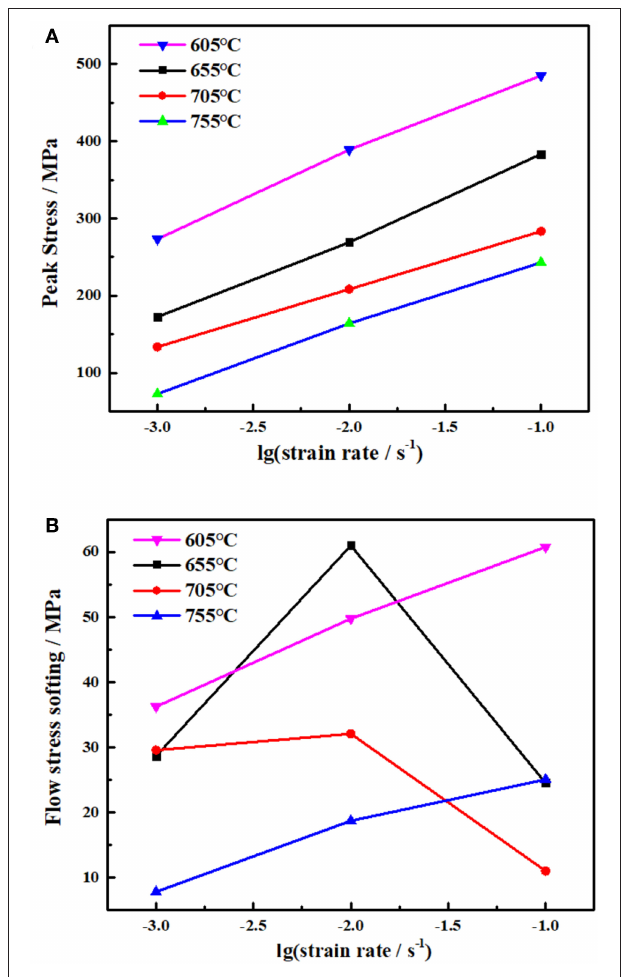
FIGURE 4 | (A) Peak flow stress for various temperatures with the increase of strain rates, and (B) flow stress softing under deferent deformation